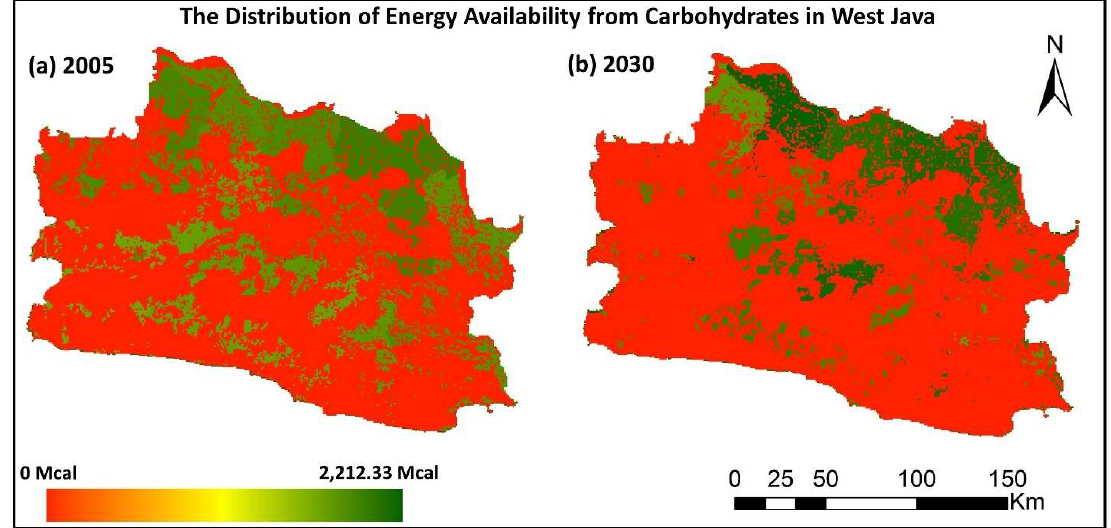
Figure 7. Food availability (carbohydrates) in West Java ( a ) in 2005 and ( b ) the predictions in 2030. Based on the results of the food status (carbohydrates) prediction in 2030 above, as